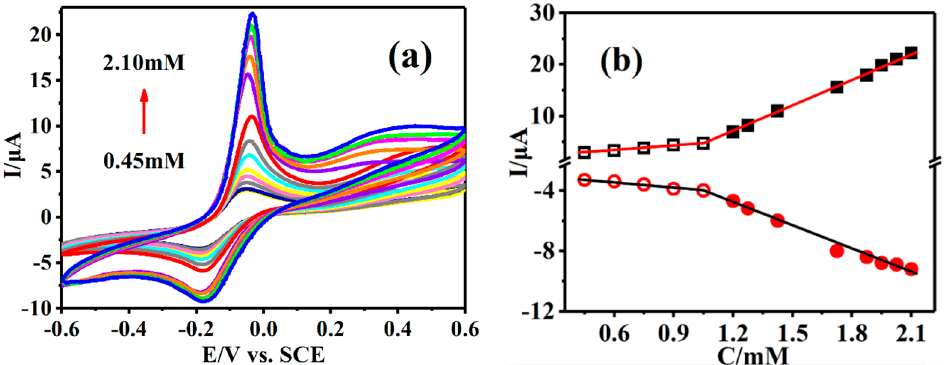
Figure 5. ( a ) CVs of Cu-TCPP@MOFs/GCE in different concentrations of AA solution. ( b ) The standard curves of the peak currents versus different concentrations of AA solution.